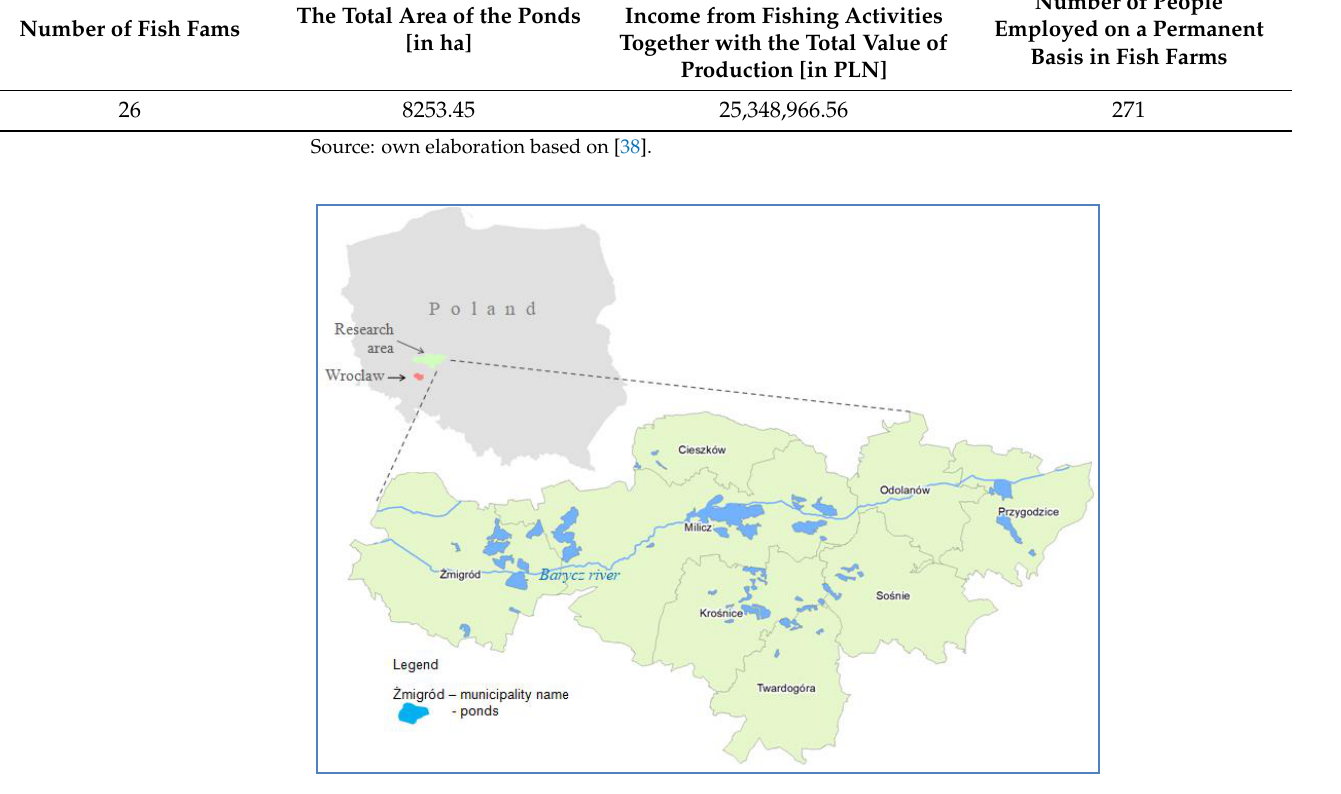
Figure 2. Barycz Valley. Source: own elaboration.